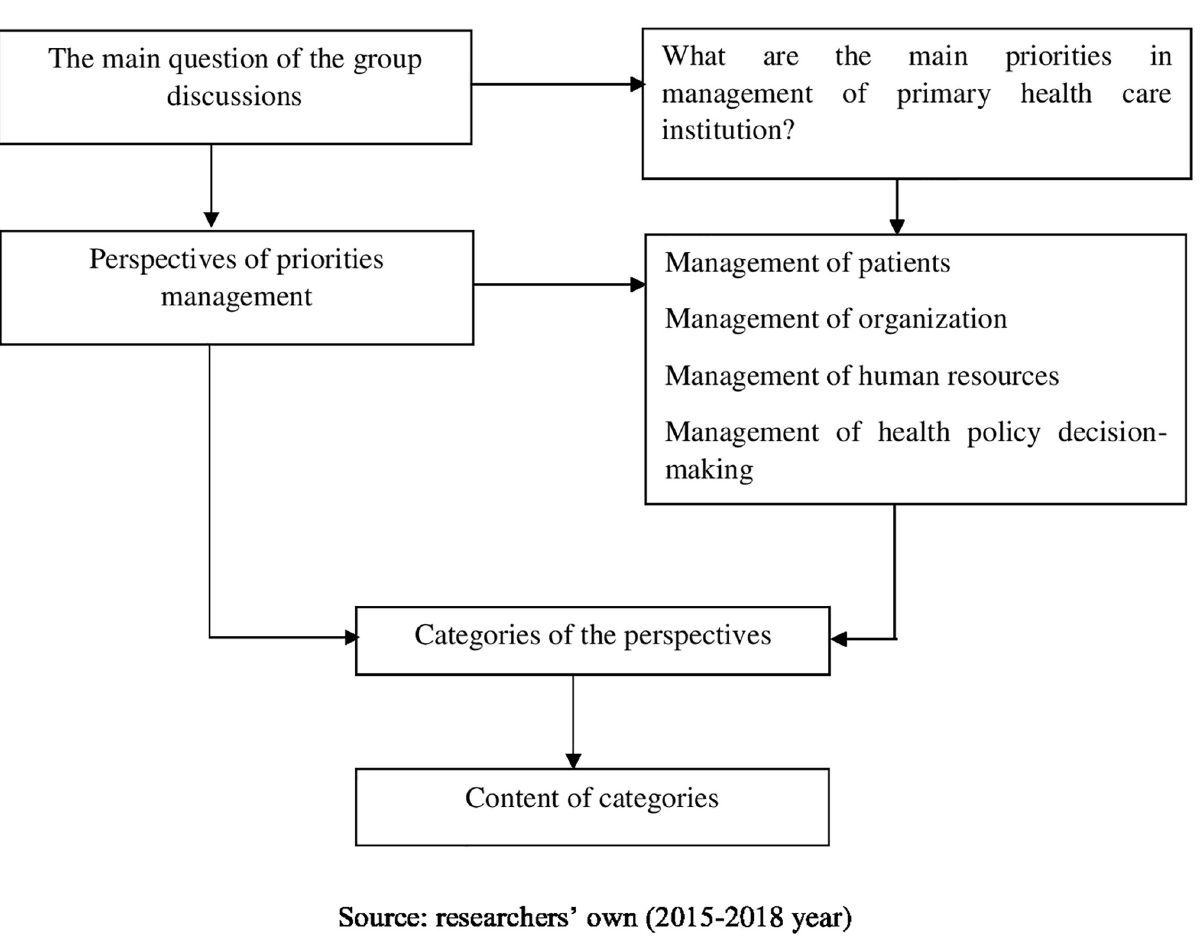
Fig 2. Proposed methodology of data